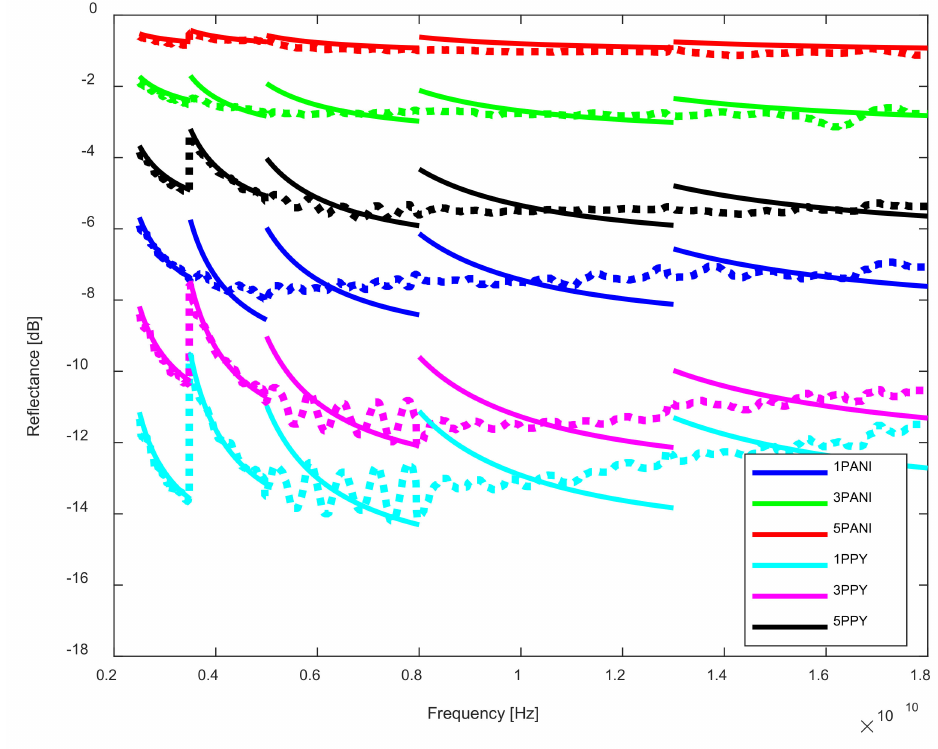
Figure 14. Model waveforms (solid) and measurement results (dotted) of reflectance in the tested frequency range from 2.5 to 18 GHz for textile samples inkjet printed with PANI and PPy conductive